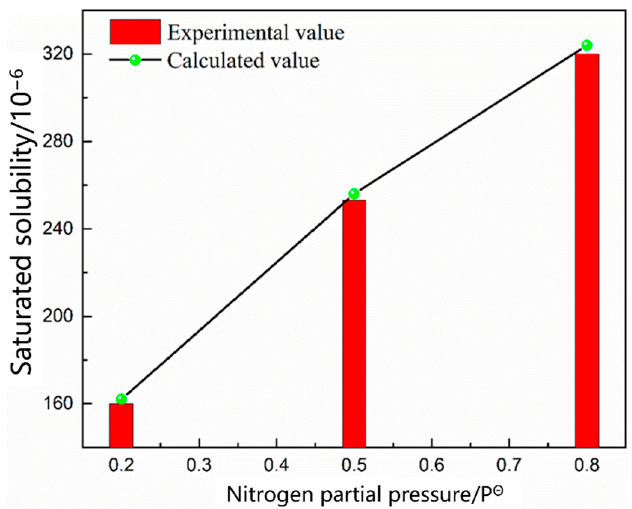
Figure 4. Effect of nitrogen partial pressure on nitrogen solubility.